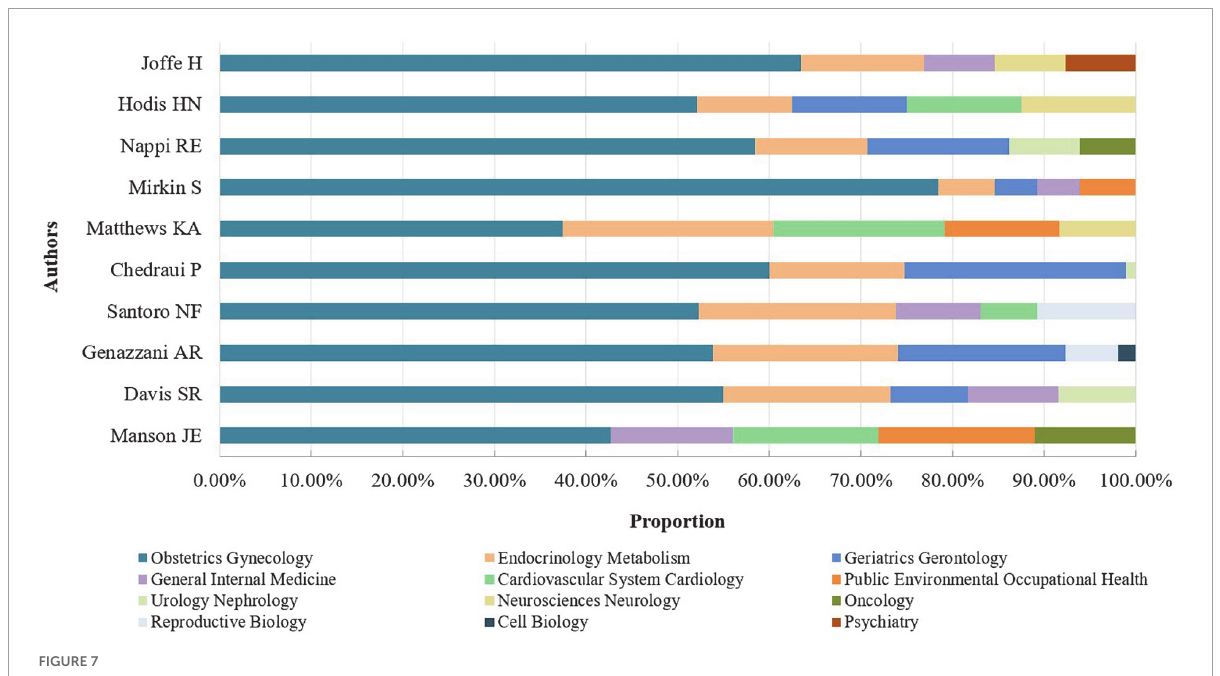
FIGURE7 Proportion of top-5 research areas for the top-10 authors.